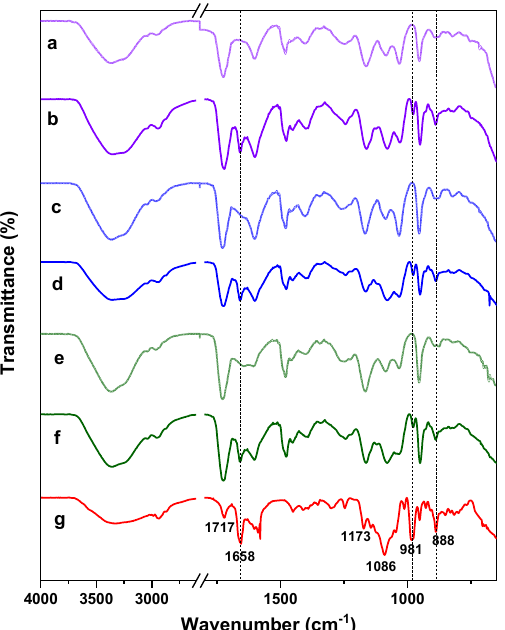
Figure 6. FTIR spectra of BTM ( g ), hydrogel H2 empty and loaded ( a ),( b ), hydrogel H4 empty and loaded ( c ),( d ), and hydrogel H6 empty and loaded ( e ),( f ).